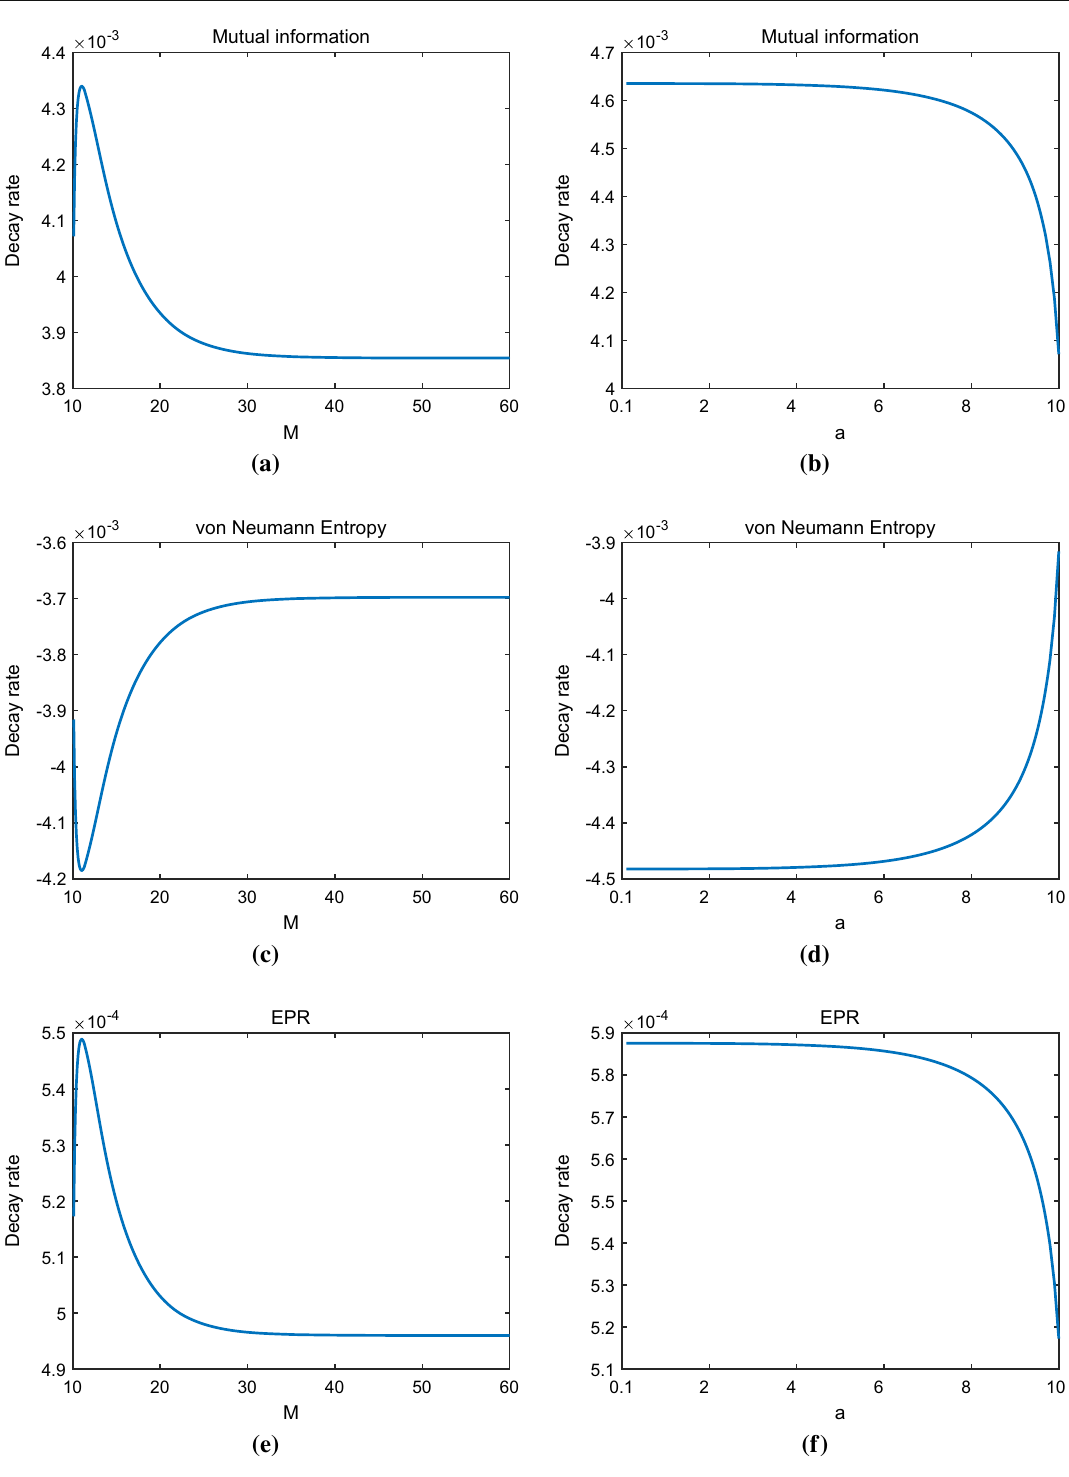
, or w.r.t. the angular momentum per mass 2